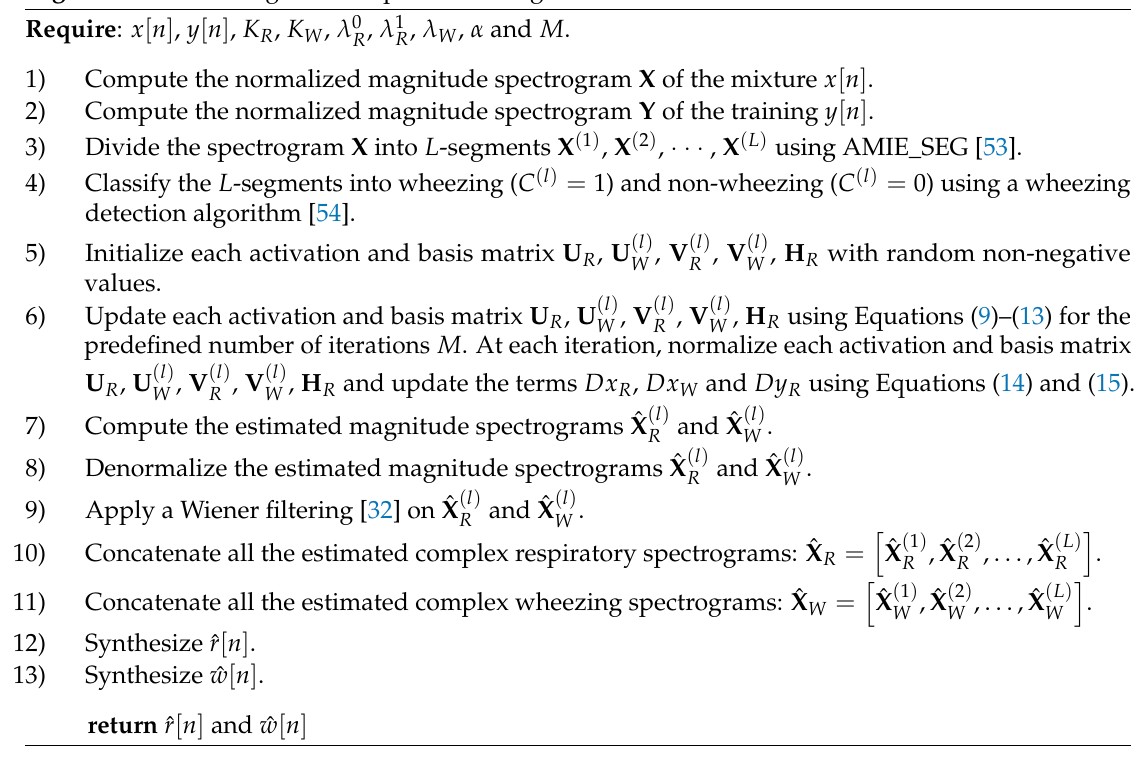
Algorithm 1 Wheezing sound separation using